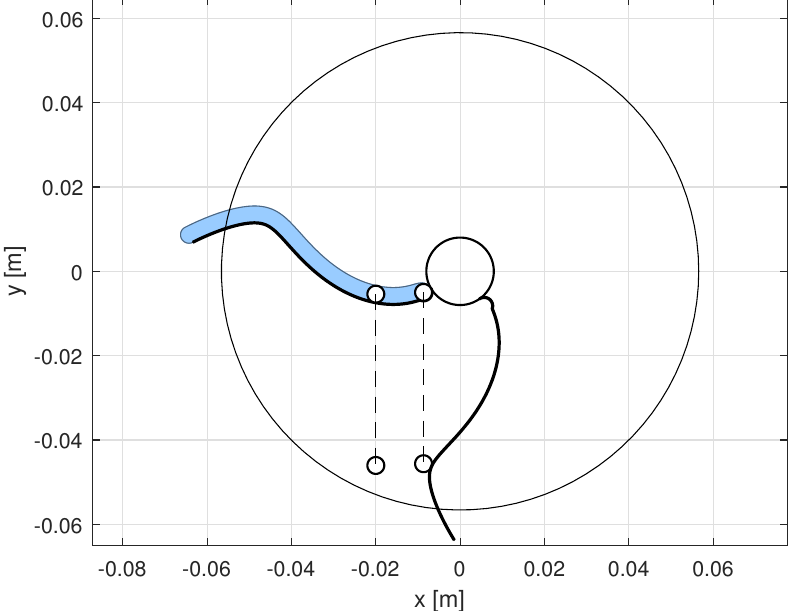
Figure 9. Comparison of trajectories of components with different starting points, at the beginning of the blade movement and after a blade rotation of about 140 ◦ . A component which starts the fall away from the rotary compartment shaft will not interact with the blade.